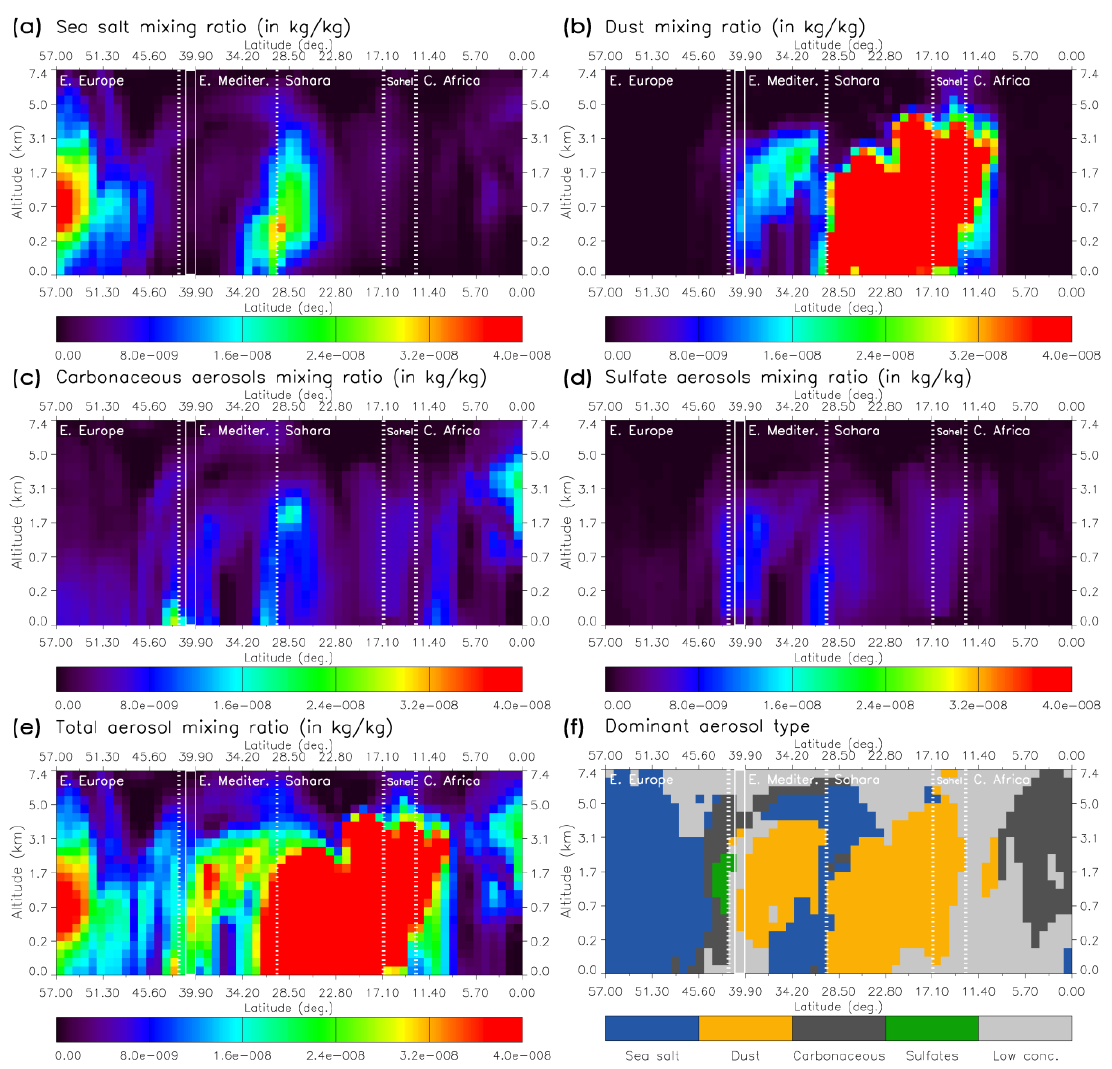
Figure 4. Vertical cross sections of the Copernicus Atmosphere Monitoring Service (CAMS) reanalysis mass mixing ratio along the CALIPSO track for sea salt ( a ), dust ( b ), carbonaceous aerosols (organic matter—black carbon)) ( c ), sulfates ( d ), and all aerosol types ( e ). Vertical cross section of the dominant aerosol type ( f ).